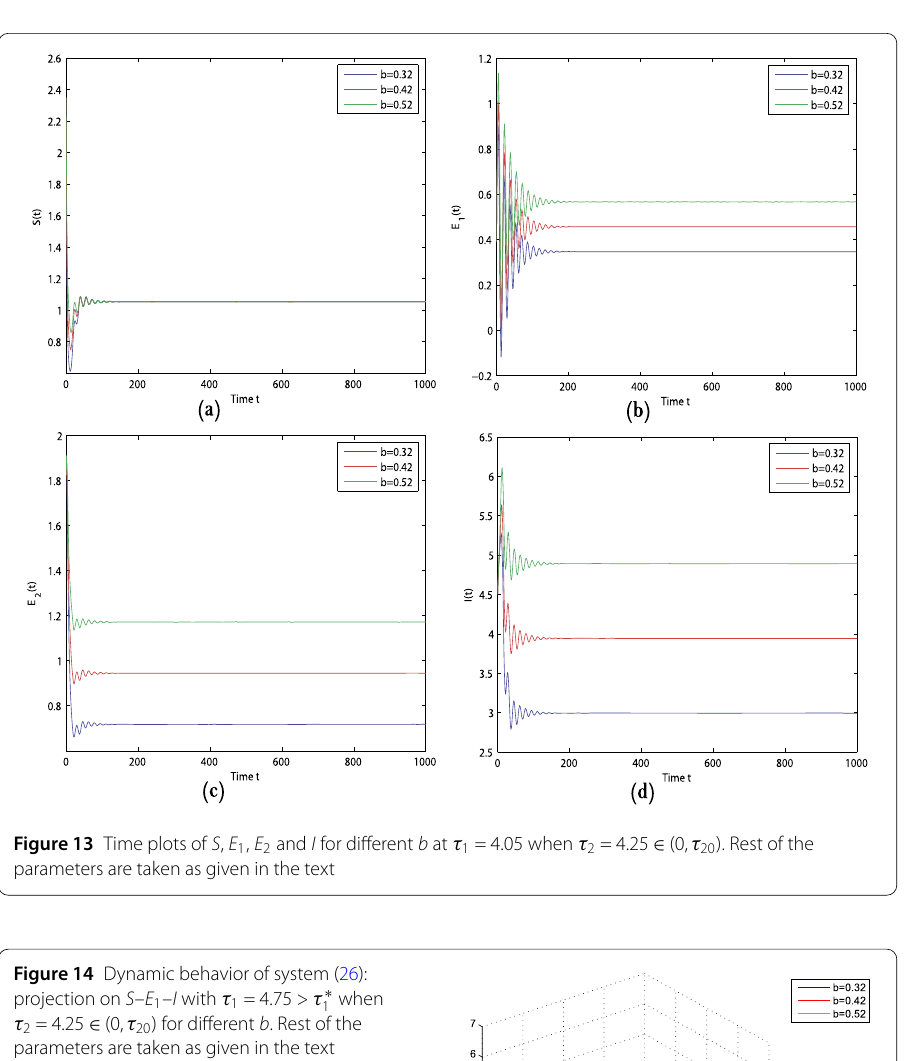
Figure 14 Dynamic behavior of system (26): projection on S – E 1 – I with τ 1 = 4.75 > τ ∗ 1 when τ 2 = 4.25 ∈ (0, τ 20 ) for different b . Rest of the parameters are taken as given in the